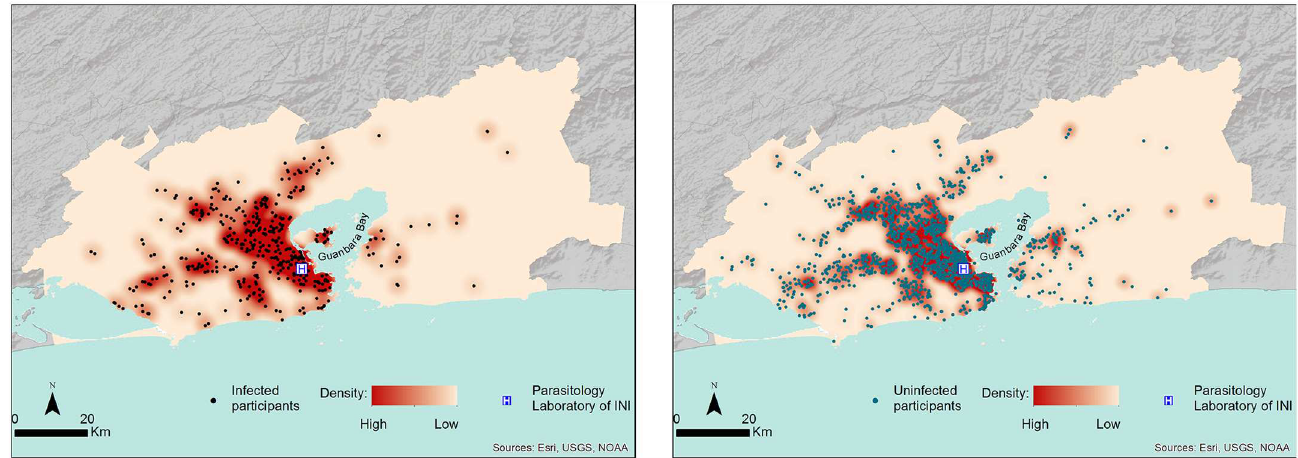
Fig 2. Geographical distribution and gaussian kernel density surfacemap of participants with and without intestinal parasites. Incidence density in the metropolitanregionof Rio de Janeiro State.